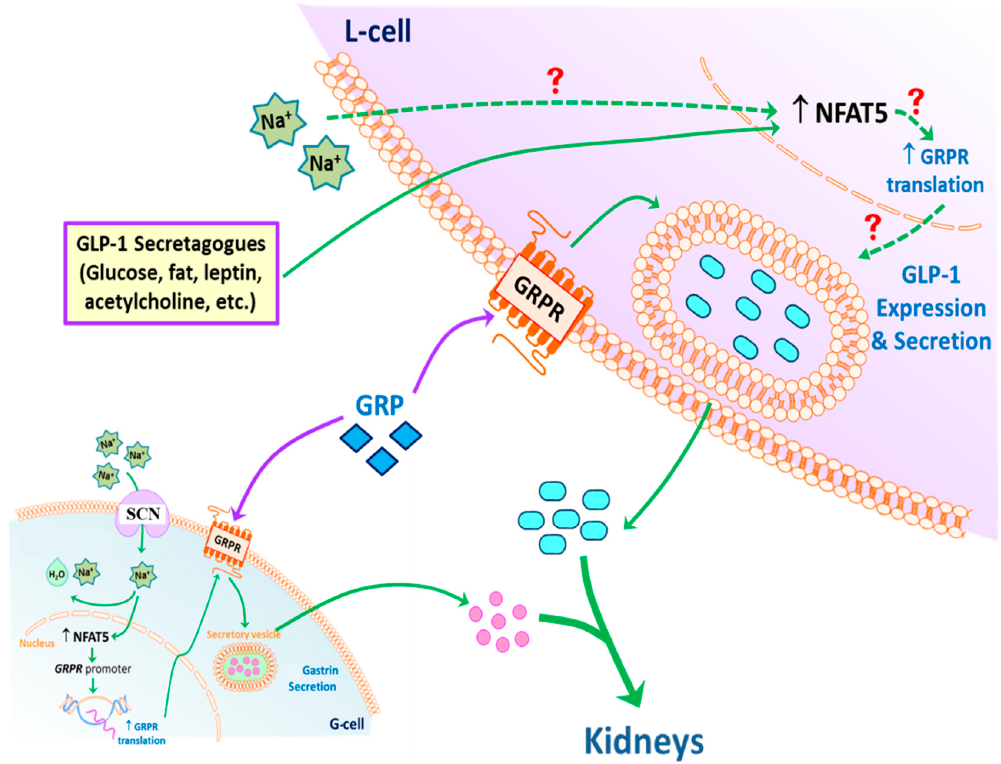
Figure 8. Potential mechanism of GLP-1 secretion. An increase in intracellular Na + , via SCN, in L-cells (and possibly G-cells) stimulates the expression of NFAT5, which increases the translation of glucagon-like peptide-1 (GLP-1). NFAT5 may also increase the secretion of gastrin releasing peptide (GRP) and transcription of GRP receptor (GRPR). High concentra- tions of GRP may potentiate the ability of sodium to increase GLP-1 secretion. The secreted GLP-1, together with gastrin, decreases renal sodium transport. This effect is facilitated by dopamine, acting via D 1 -like receptors (D 1 R and D 5 R) to increase sodium excretion, especially during moderate volume expansion. Exposure of L-cells to low intracellular Na + also increases the expression of NFAT5 but does not stimulate GLP-1 secretion, the cause of which remains to be determined. 4. Materials and Methods 4.1. Cell Culture and Reagents The NCI-H716 intestinal cell line (ATCC ® CCL-251™, Manassas, VA, USA) (L-cells), originally obtained from ascitic fluid of a 33-year-old Caucasian male with poorly differ- entiated adenocarcinoma of the colon, was used to study the regulation of GLP-1 expres- sion and secretion [19]. The L-cells were grown in suspension in RPMI 1640 (ATCC, #30-2001, Manassas, VA, USA), supplemented with 10% FBS, 100 IU/mL penicillin, and 100 μ g/mL streptomycin in a 37 °C incubator with 5% CO 2 and 95% humidity. Penicillin, streptomycin, and FBS were from Thermo Fisher Scientific (Waltham, MS, USA). GRP (#AS-24213 AnaSpec Inc., Fremont, CA, USA) was dissolved in sterile deionized water. Immortalized hRPTCs [47], isolated from a normotensive Caucasian male, were grown in DMEM/F-12, supplemented with 2% fetal bovine serum, containing epidermal growth factor (10 ng/mL), insulin, transferrin, and selenium cocktail (5 μ g/mL each), and dexame- thasone (4 ng/mL), in a 37 °C incubator with 5% CO 2 and 95% humidity. The primary antibodies were: rabbit polyclonal anti-GRPR (1:1000, #PA5-27073); rab- bit polyclonal anti-GLP-1 (1:500, #710320) antibodies (Thermo Fisher Scientific, Waltham, MS, USA), rabbit polyclonal anti-NFAT5 (1:1000, GTX110903); mouse monoclonal anti- GAPDH (1:10000, GTX627408) antibodies (Genetex, Irvine, CA, USA), and mouse mono- clonal anti- α -tubulin (1:10000, T5168) antibodies (Sigma-Aldrich, St. Louis, MO, USA).